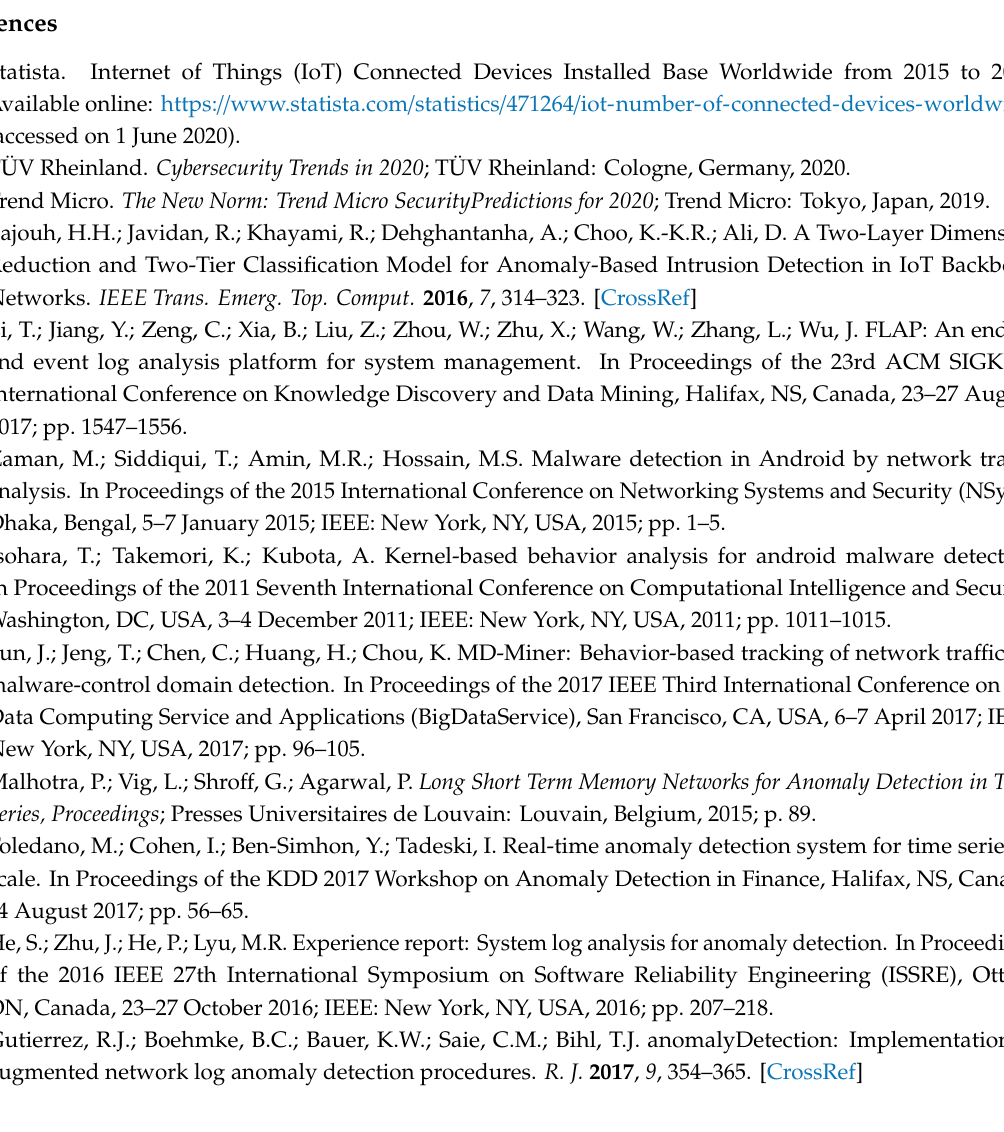
Figure A2. Attack Profile C & C access suspicious scenario due to malware infection.